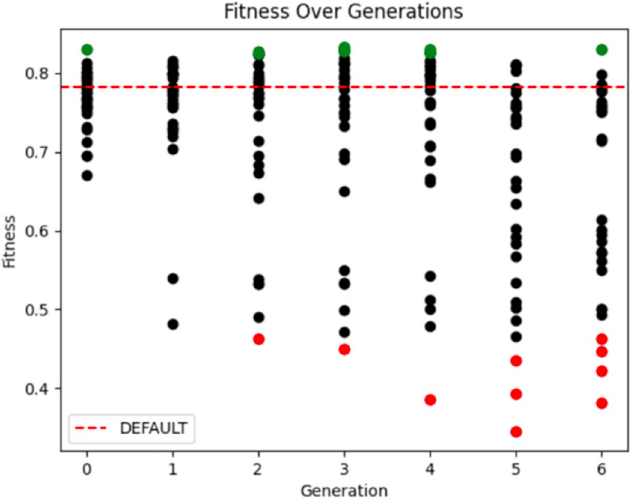
Fig 12. Evolution of fitness performance of chromosomes (i.e., different parameter sets) over time within the GA optimization in prostate segmentation. The y-axis represents the fitness score for each chromosome in a population, representing the weighted average of the prostate segmentation performance of the apex, base, and whole prostate regions, averaged across the cases of the KNoLO tuning set. For comparison, the red dotted line demarcates the performance of the prostate segmentation SN using only hand-tuned parameters by a data scientist. Each generation (iteration) has 30 chromosomes, with the green points representing the highest fitness chromosomes and the red points representing the lower fitness chromosomes. The highest fitness score was 0.833.